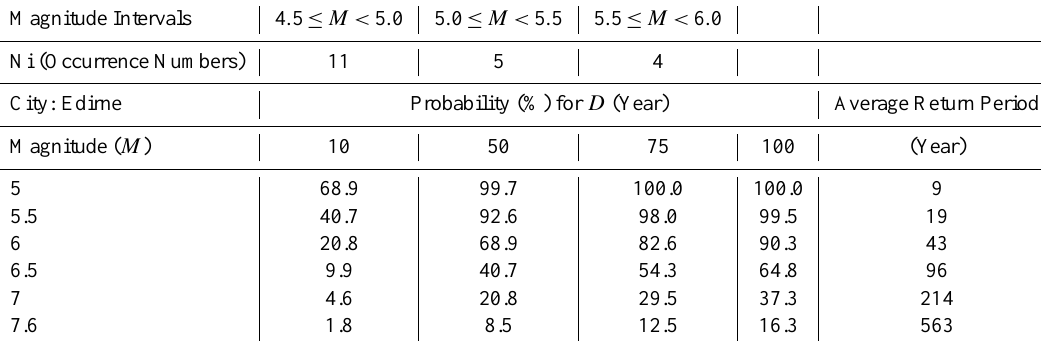
Table 3h. Earthquake occurrence probability (%) for D (Year) for Edirne city. Magnitude